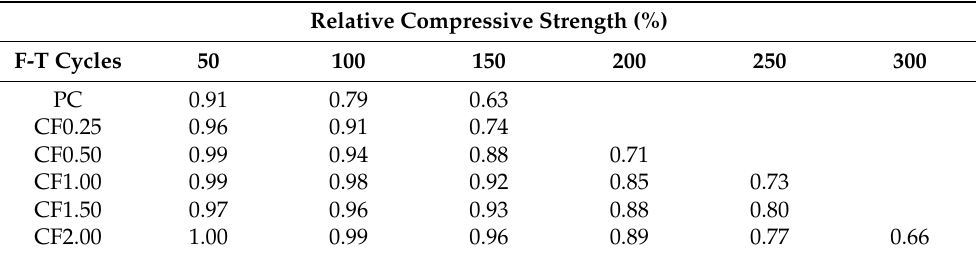
Table 6. Relative compressive strength of the concrete in the frost resistance